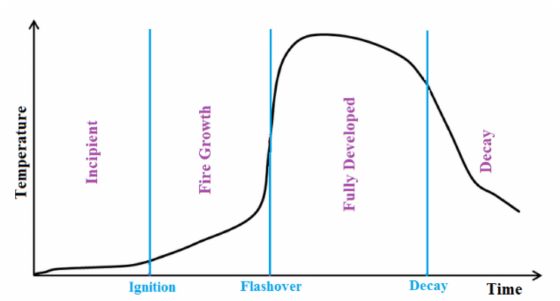
Figure 1. Traditional fire